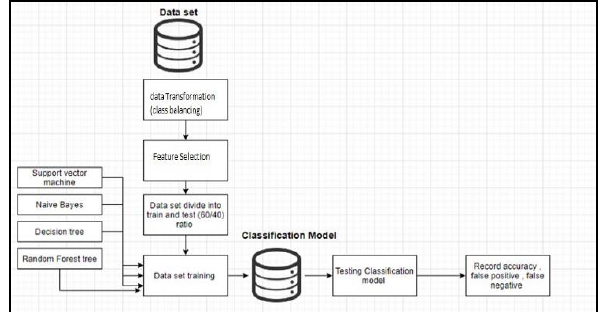
Figure 2. Mechanisms followed in the proposed